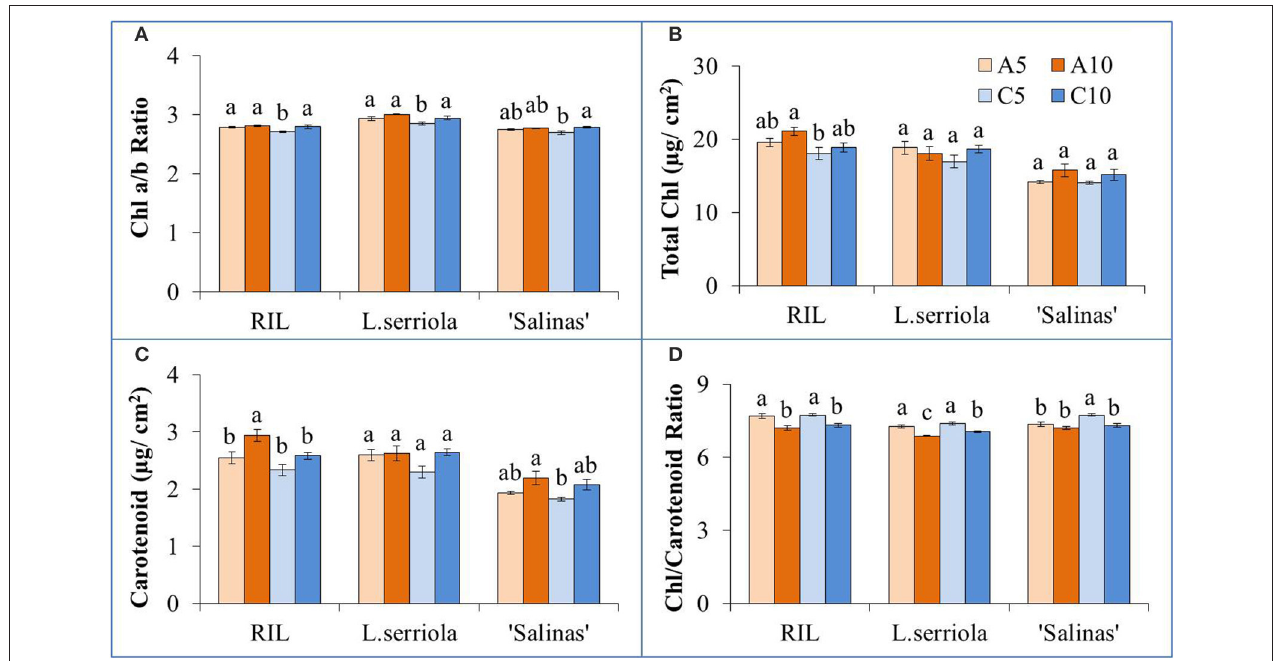
FIGURE 3 | (A) Chlorophyll a/b ratio, (B) total chlorophyll concentration, (C) carotenoid concentration, and (D) chlorophyll/ carotenoid ratio of L. serriola , “Salinas” and RIL grown in A5, A10, C5, and C10. Each bar graph is the mean of 4 measurements from at least 4 different plants ( n ≥ 4). Vertical bars represent